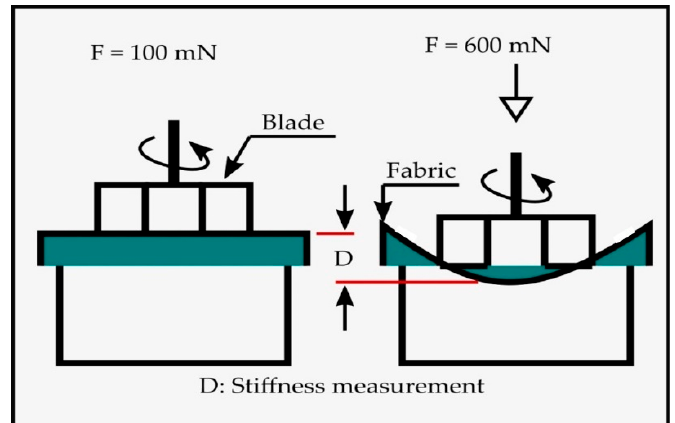
Figure 3. Technical principle of TSA by sound analysis and deformation measurement: ( a ) Measuring of smoothness; ( b ) measuring of softness, and ( c ) measuring of stiffness ("Reproduced/Adapted with permission from [emtec Electronic GmbH, Leipzig, Germany], Alexander Grüner, Emtec TSA –